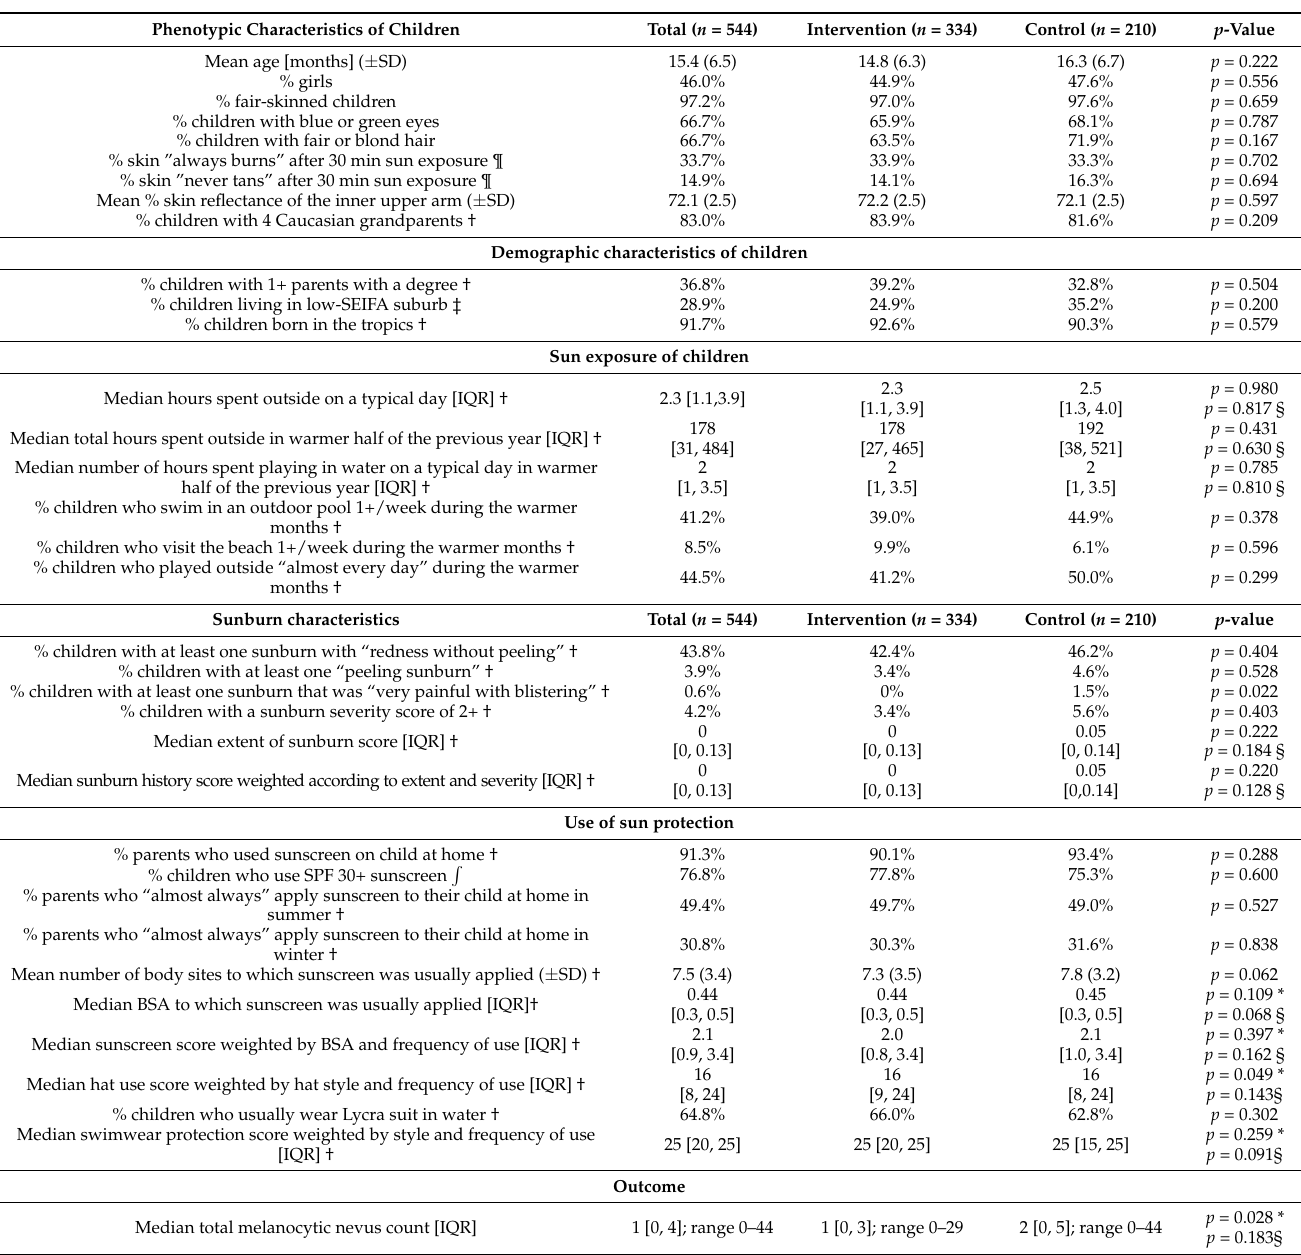
Table 2. Baseline characteristics of 544 Australian children (1–35 months-old) attending 25 childcare centers in Townsville, Australia, who had a follow-up examination for melanocytic nevi (MN). Results were adjusted for cluster